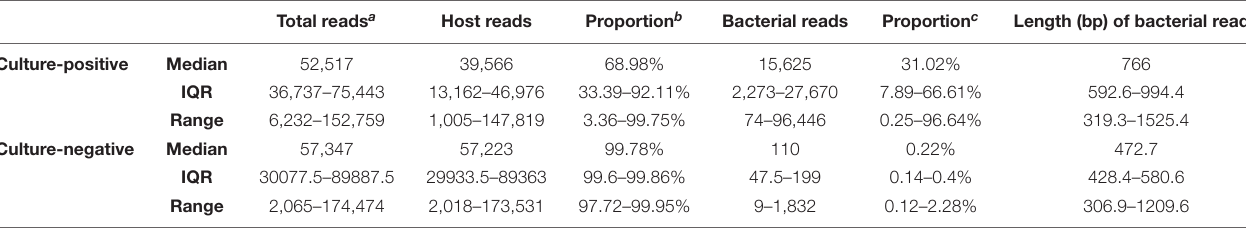
TABLE 2 | Comparison of reads information between culture-positive and culture-negative